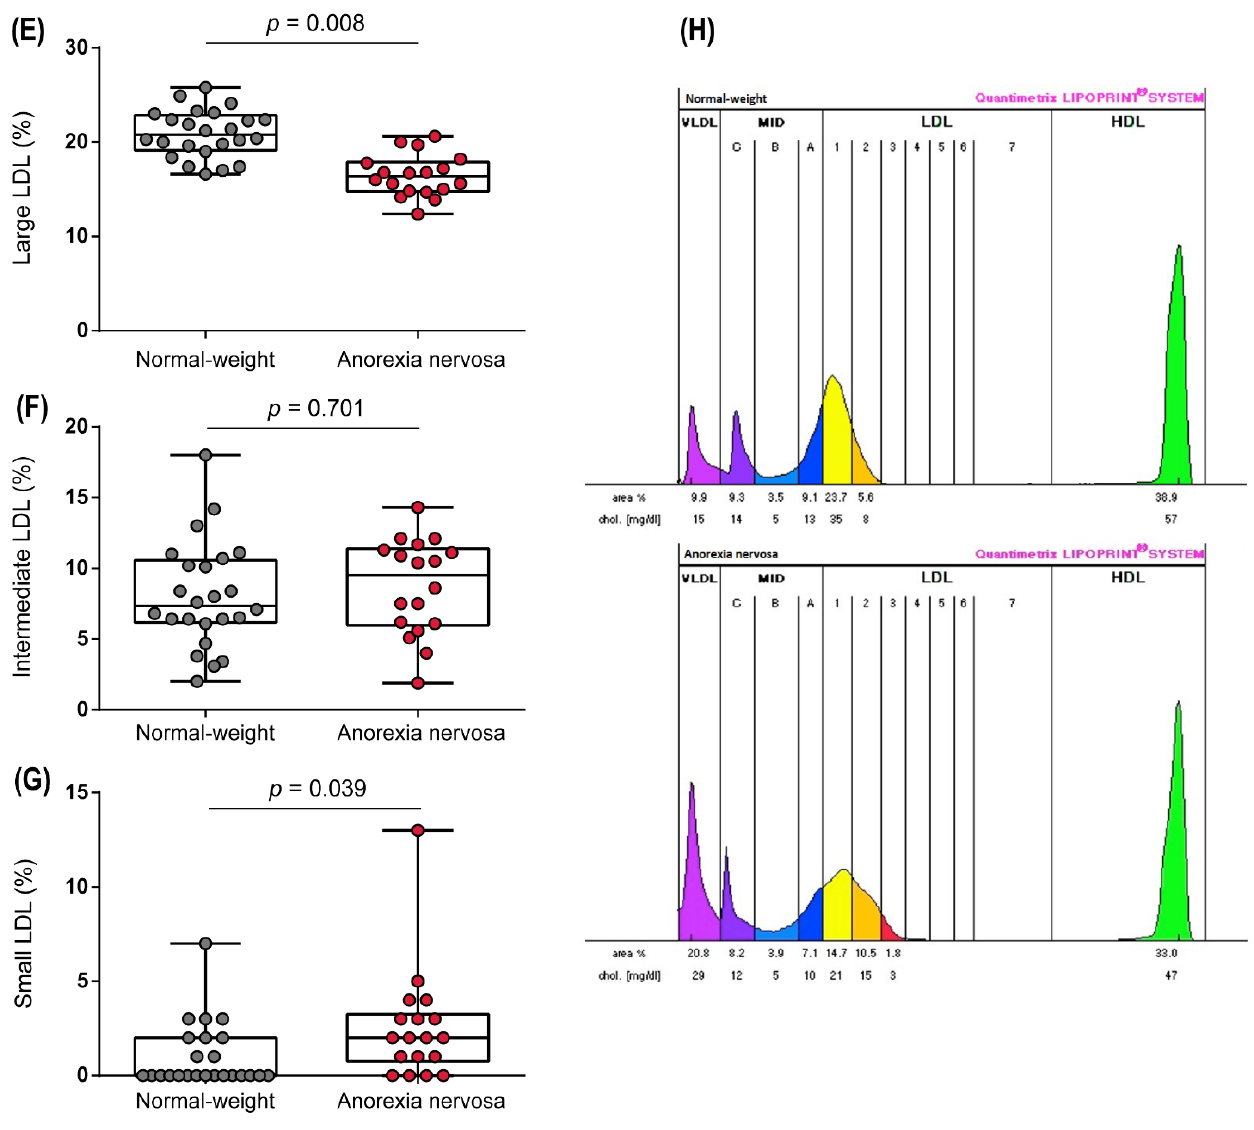
Figure 1. Subclass distribution of low-density lipoproteins. Using the Lipoprint system ® , lipopro- teins were separated into VLDL ( A ) and the intermediate-density lipoprotein subclasses IDL-C ( B ), IDL-B ( C ) and IDL-A ( D ). Distribution of LDL subclasses was assessed ( E – G ). The percentage of each subclass was calculated as the proportion of total plasma cholesterol measured before the analyses. A representative Lipoprint result chart of one normal-weight and one AN woman is shown ( H ). Depending on the normal distribution of the data, t-test ( A – F ) or Mann–Whitney U test ( G ) was used to analyze differences between the two groups. Individual data are presented on top of box- plots showing median, interquartile range, and minimum and maximum values. Adjusted p -values according to Benjamini–Hochberg are displayed.